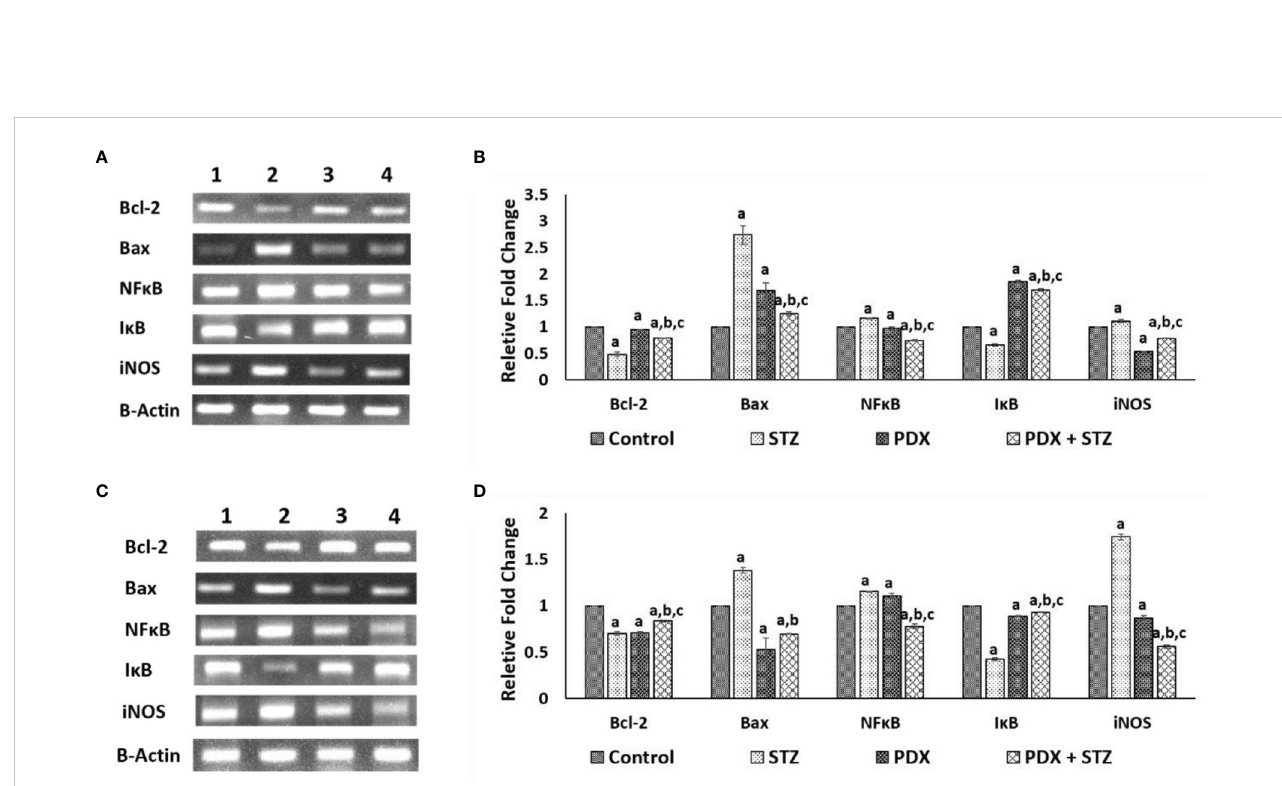
FIGURE 4 Gene expression studies in Type 1 DM and Type 2 DM mice pancreatic tissue. Expression of anti-apoptotic gene: Bcl-2, apoptotic gene: Bax in Type1 DM (A, B) and Type 2 DM (C, D) mice pancreatic tissue when treated with PDX and STZ simultaneously. The levels of all genes quanti fi ed by densitometric analysis. Gene expressions were normalized by b -actin gene expression. (1) Control, (2) STZ, (3) PDX, (4) PDX + STZ. All values are expressed in mean + SEM. N=3. a,b,c p < 0.05 compared to control, STZ and PDX respectively. STZ, Streptozotocin; PDX,